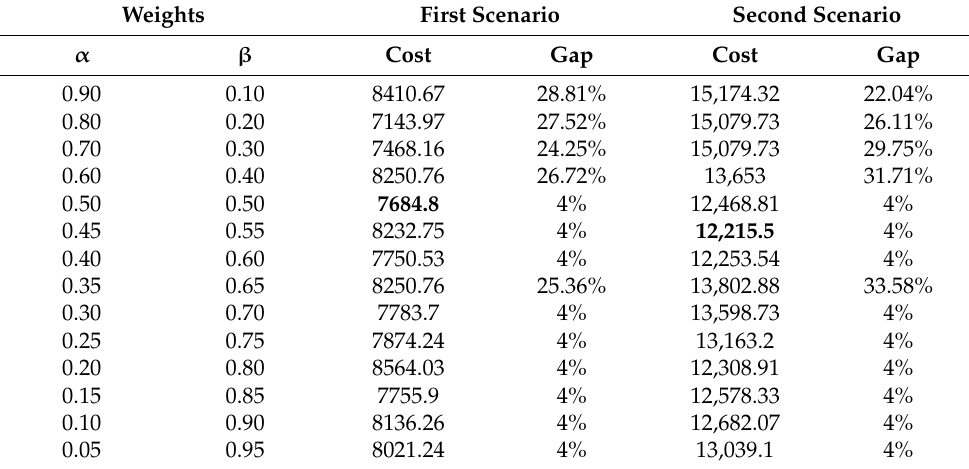
Table 3. Relationship of flows between